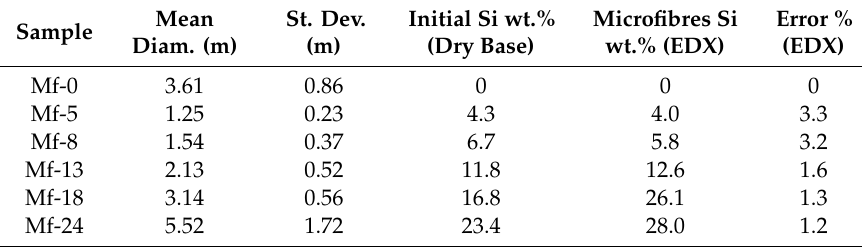
Figure 1. SEM images of microfibres coatings. Table 2. Dimensional and compositional characteristics of the electrospun microfibres. Si wt.% (EDX) is the average value measured on the same regions of the SEM images of Figure 1.